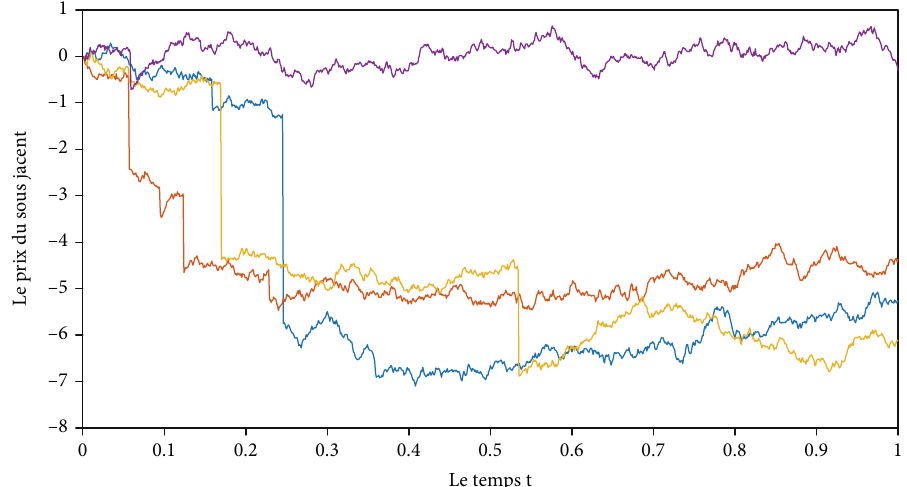
Figure 2: Modeling asset price paths under Lévy jump-di ff usion λ